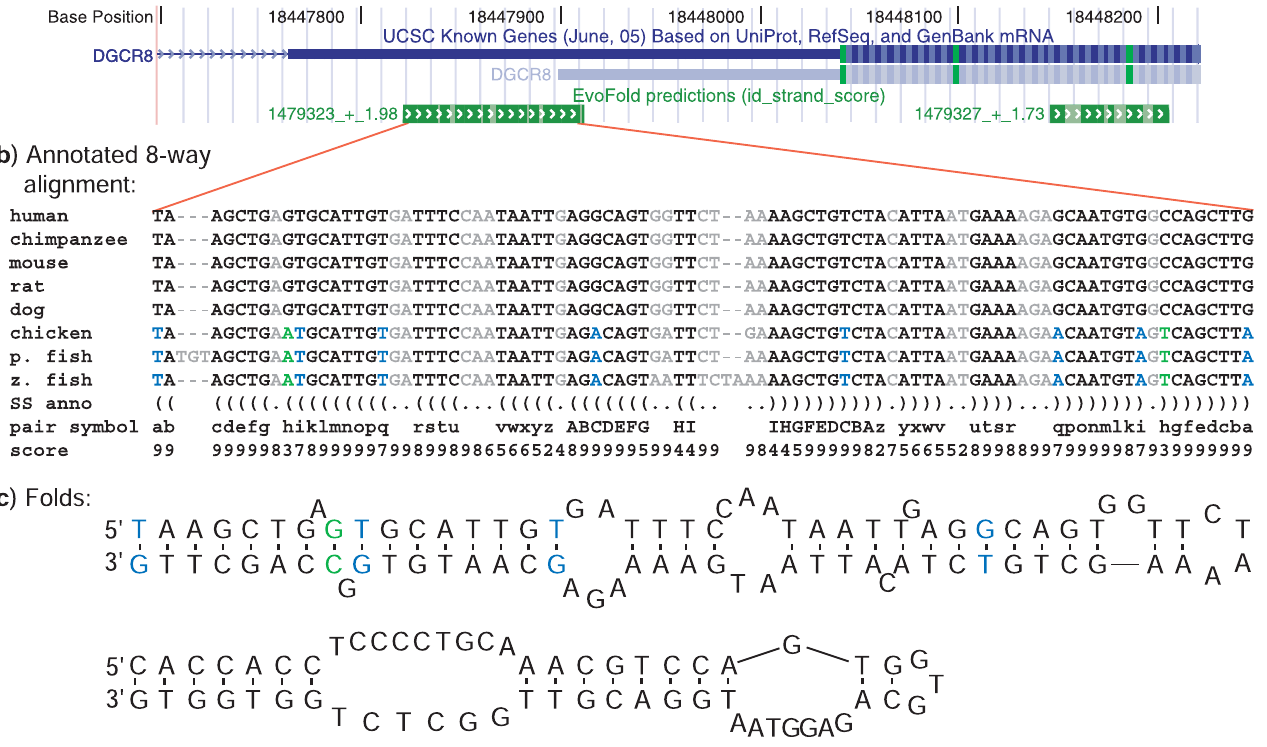
Figure 5. 5 9 UTR miRNA-Like Hairpin and Coding Hairpin in Gene (DGCR8) Involved in miRNA Processing (A) Gene structure and EvoFold predictions are shown around the first exon of DGCR8 . (B) Annotated segment of the eight-way alignment spanning the long, miRNA-like 5 9 UTR-hairpin (see Figure 3B for legend). (C) Depiction of folds. DOI: